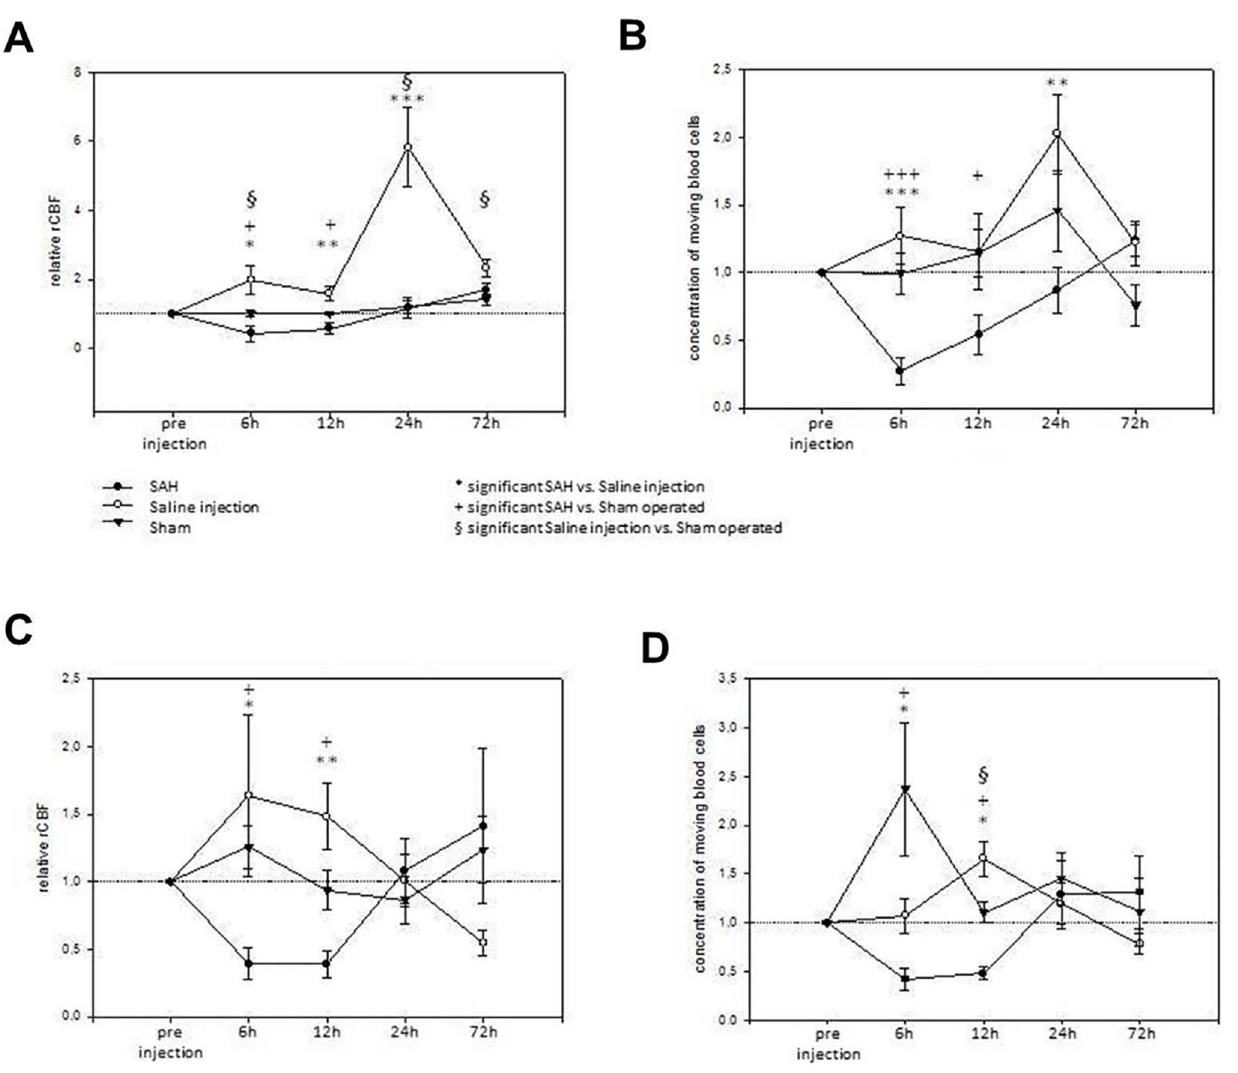
Fig. 3. Cerebral and cerebellar rCBF impairment during DCI. Fig. 3 summarizes impairment of regional cerebral blood flow and the concentration of moving blood cells in the S1 and cerebellar cortex related to pre-injection values at time points 6, 12, 24 and 72 hours after injection. A: relative rCBF in the S1 cortex. B. concentration of moving blood cells in the S1. C. relative rCBF in the cerebellar cortex. D. concentration of moving blood cells in the cerebellar cortex. Note the delayed perfusion impairment in the SAH group 6 and 12 hours after injection and interestingly, the significant and long-lasting hyperperfusion that is caused by saline